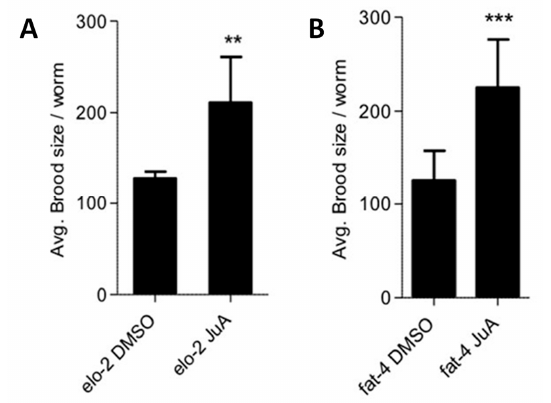
Figure 7. Recovery of brood size of fat-3(wa22) C. elegans RNAi knockdowns. Brood size of fat-3(wa22) C. elegans where RNAi knockdowns of elo-2 and fat-4 were performed showing a significant improvement after supplementation of JuA. ( A ) Recovery in brood size in elo-2 (** p < 0.001) C. elegans. ( B ) Recovery in brood size in fat-4 (*** p < 0.0001). All brood size experiments were carried out with n = 5 animals per condition in three independent trials. Data show mean values ± SD.